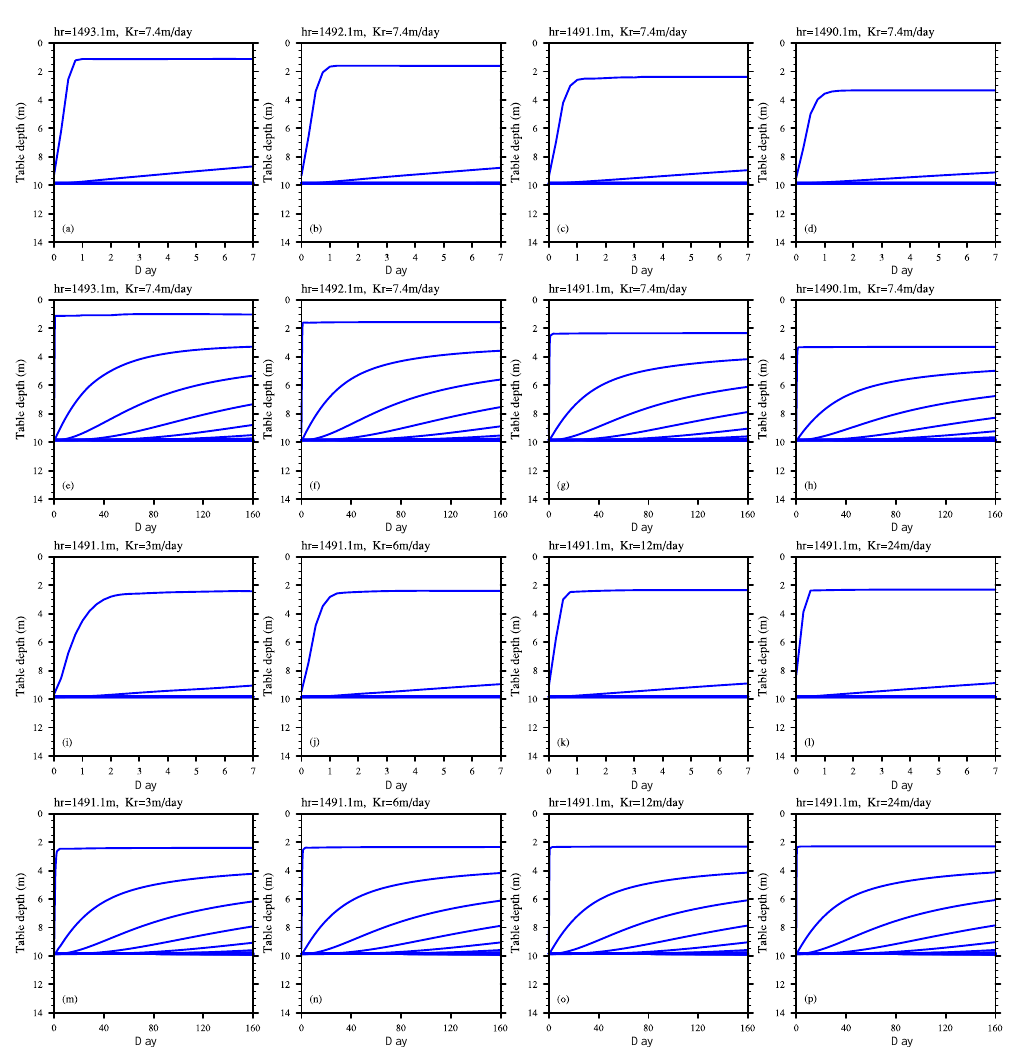
Figure 4. Short-term (a–d , i–l) and long-term (e–h , m–p) responses of the riparian groundwater table to the river water level h r and riverbed hydraulic conductivity K r in the case of the river recharging the groundwater. Time series of the simulated groundwater table depths for each grid cell in the first sensitivity experiment (a–h) . Time series for the second sensitivity experiment (i–p)